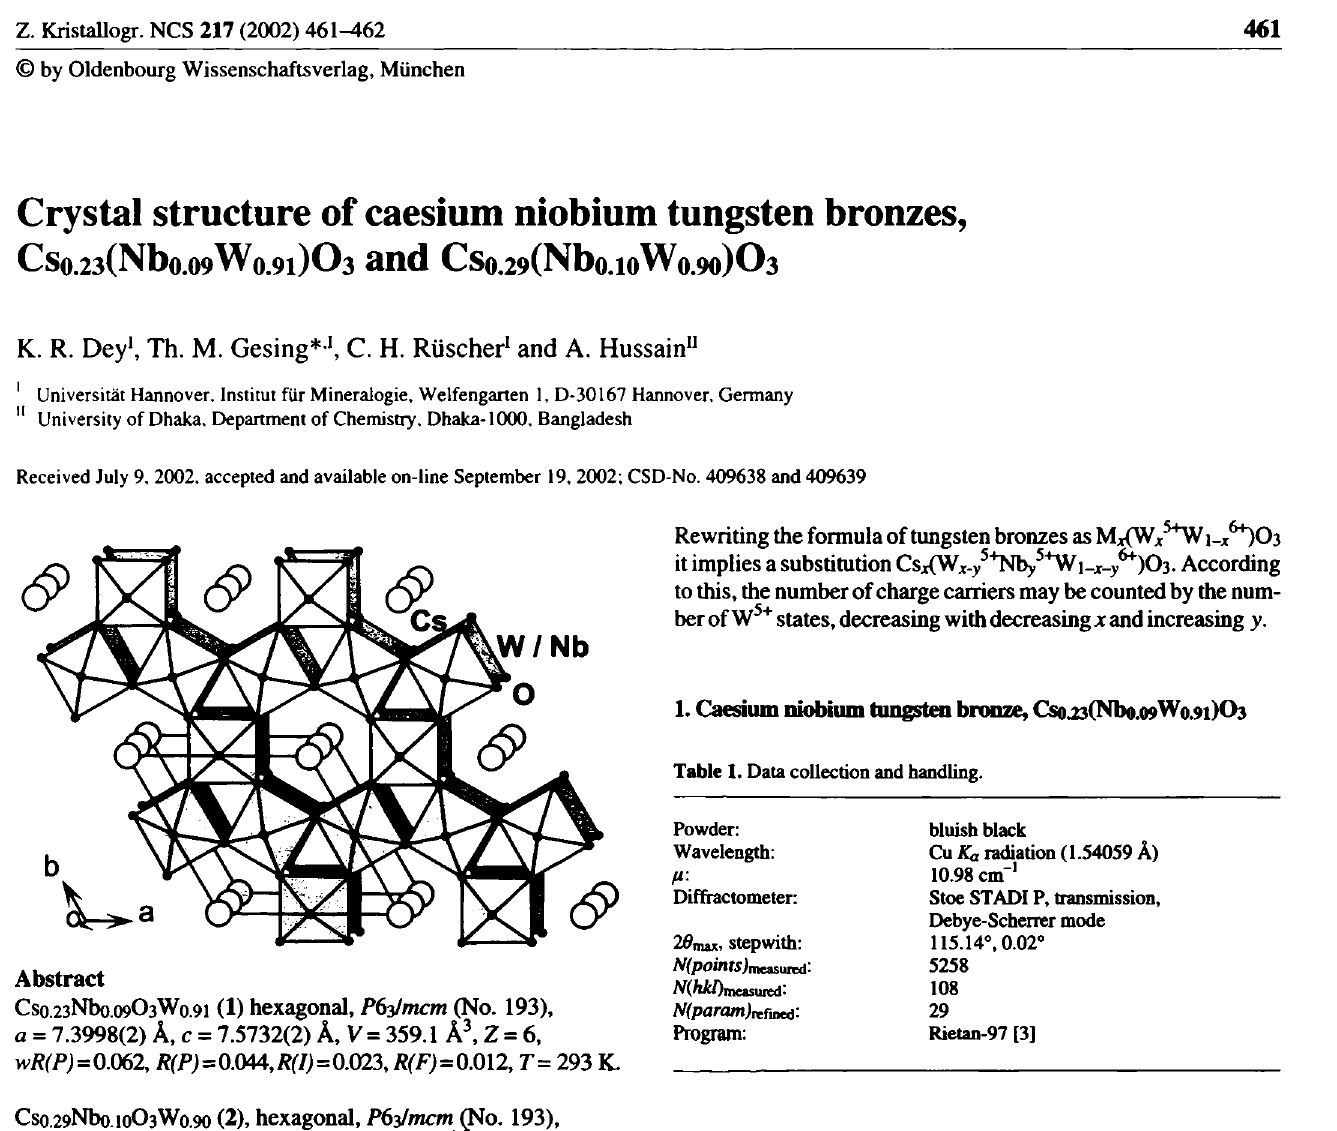
Table 2. Atomic coordinates and displacement parameters (in Â 2 ).